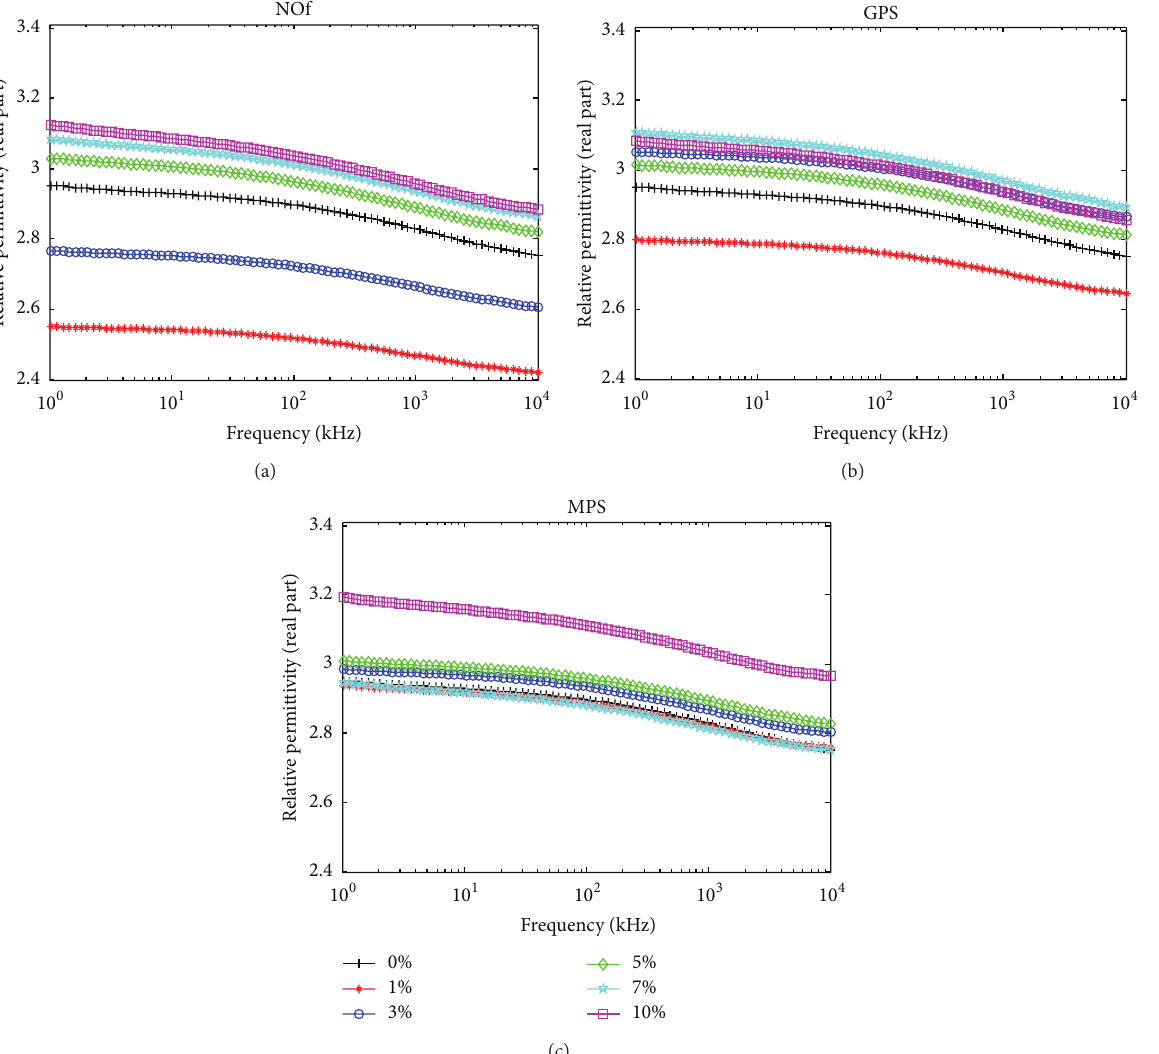
Figure 6: Relative permittivity ( 𝜀 ) as a function of the applied frequency ( 𝑓 ) for systems filled with nonfunctionalized (a), GPS functionalized (b), and MPS functionalized (c) alumina